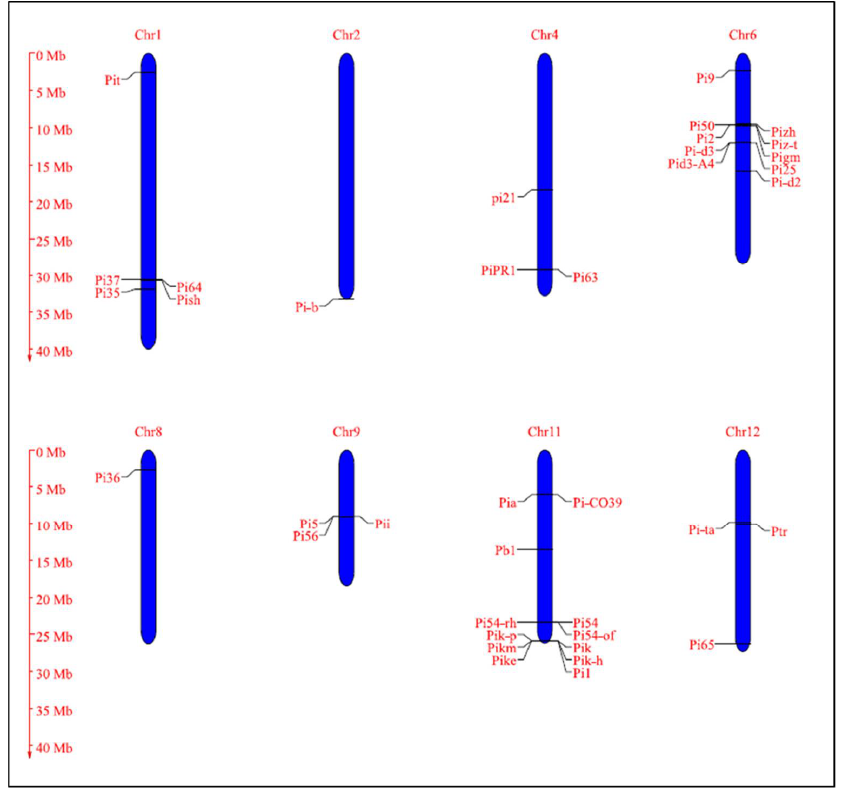
Figure 7. Cloned and characterized blast resistance genes on different chromosomes.